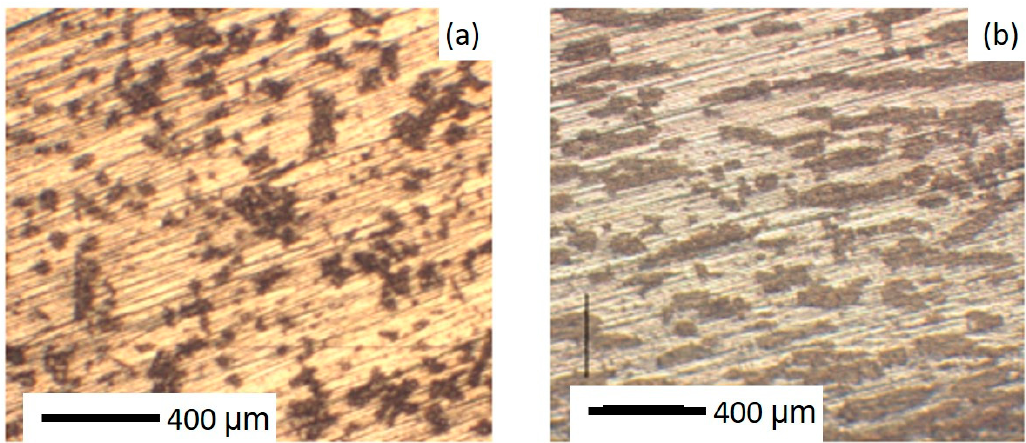
Figure 1. Optical micrographs of a sample of 35 at.% MnBi in a Bi matrix: ( a ) prior to the magnetic anneal; ( b ) after the magnetic anneal. The MnBi are the dark areas, while the lighter areas are the Bi matrix. The annealing process induces a shift from apparently equiaxial to obviously elongated MnBi grains.